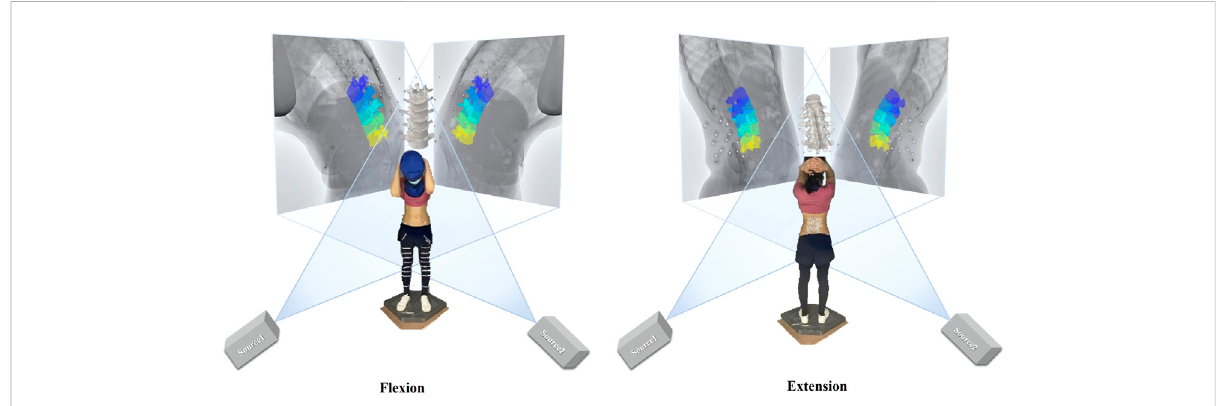
FIGURE 2 Experimental setup of the dual fl uoroscopic system for capturing lumbar spine and marker positions in vivo ; virtual reproduction of the dual fl uoroscopic system and vertebral